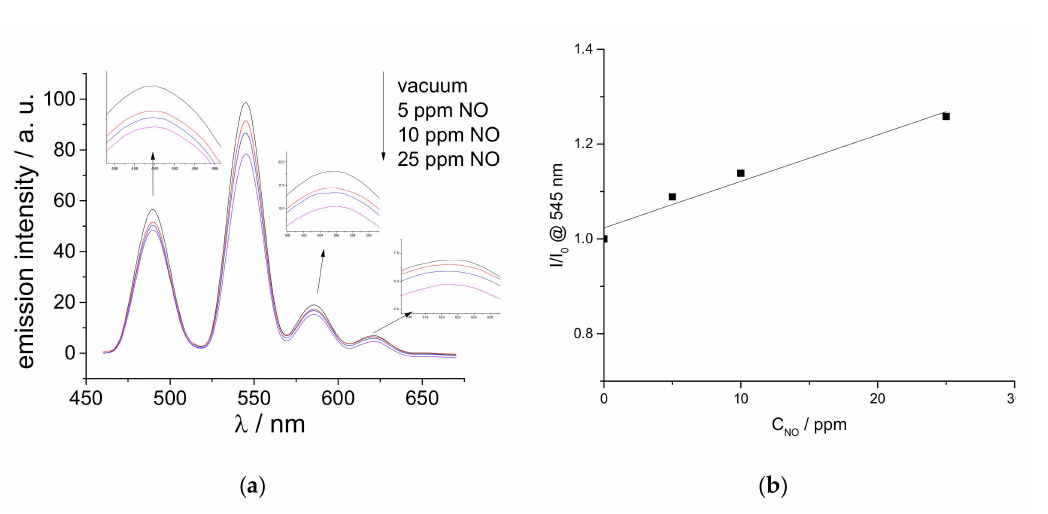
Figure 4. ( a ) Emission spectra of TbL@Si wafer exposed to various concentrations of gaseous NO at 298 K, λ exc = 230 nm, ( b ) Stern–Volmer plot for the data, measured at an emission energy of 545